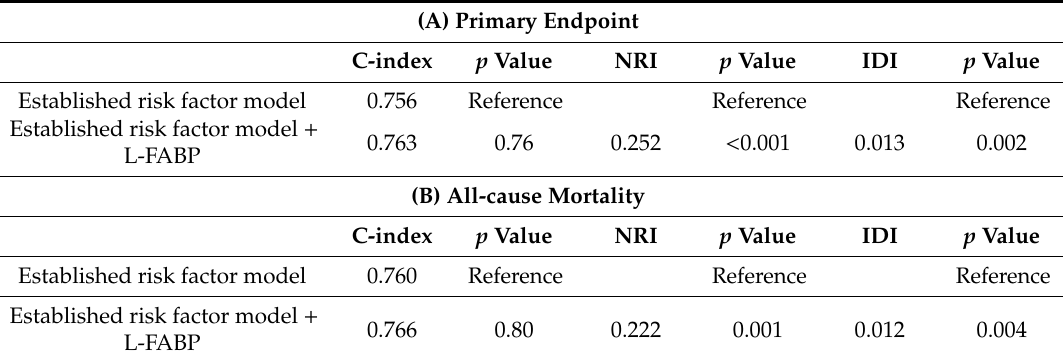
Table 4. Discrimination and reclassification of